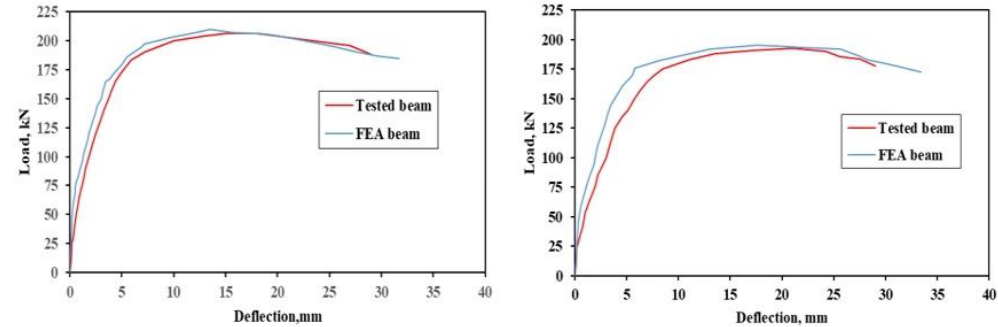
Figure 17: The experimental and numerical results of load-midspan deflection curves of the specimens PB1 (left) and PB2 (right)